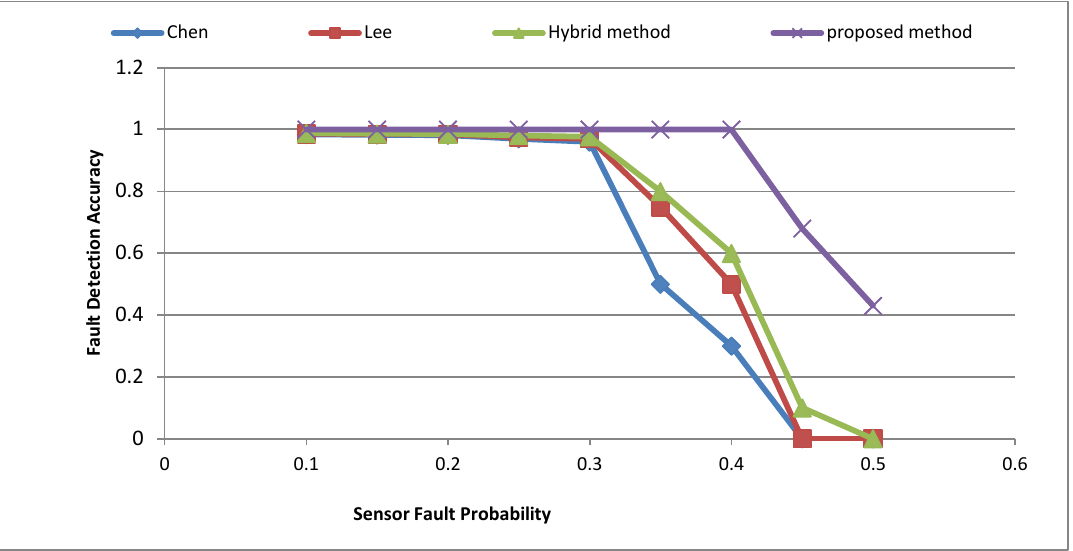
Figure 7. Fault detection accuracy when N =100.